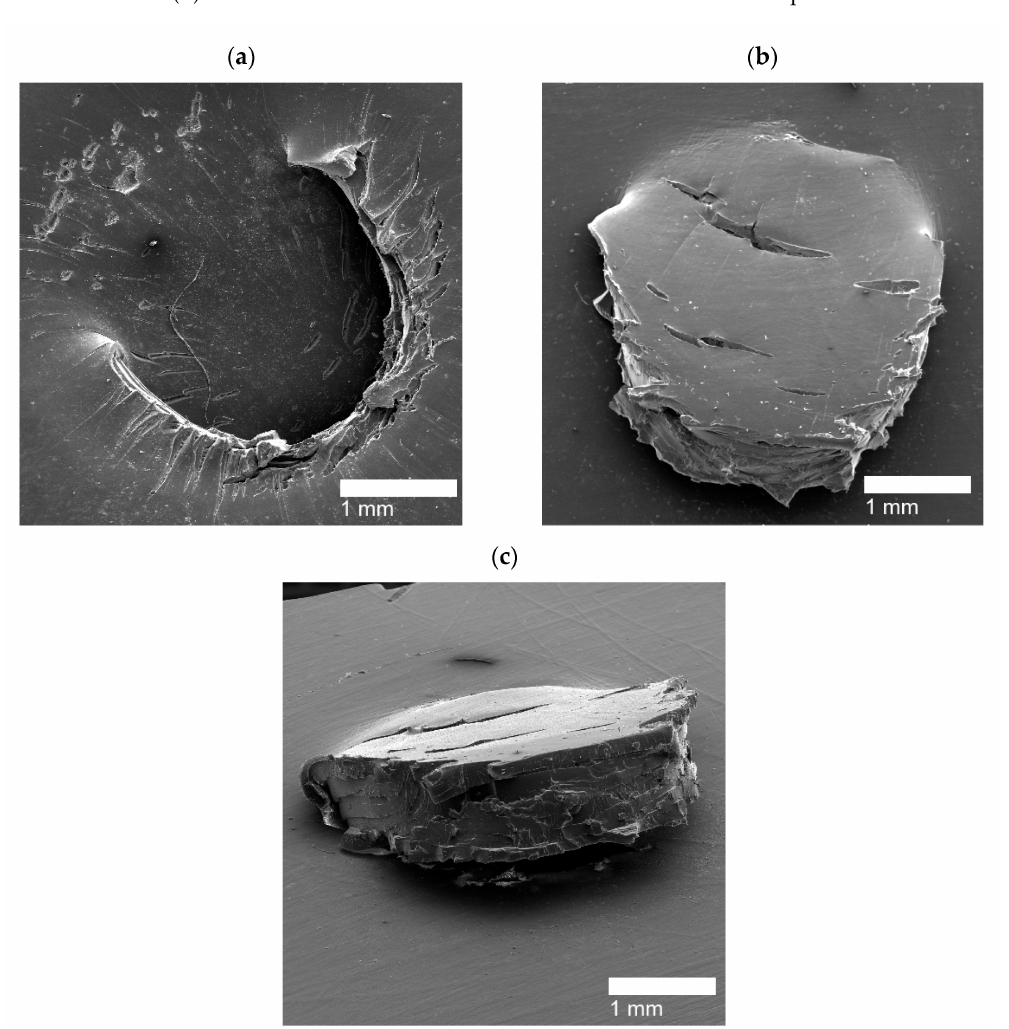
Figure 12. SEM image ( a ) shows the entry side, SEM image ( b ) shows the exit side, and SEM image ( c ) shows the diagonal view of the exit side of the door-flap puncture site for